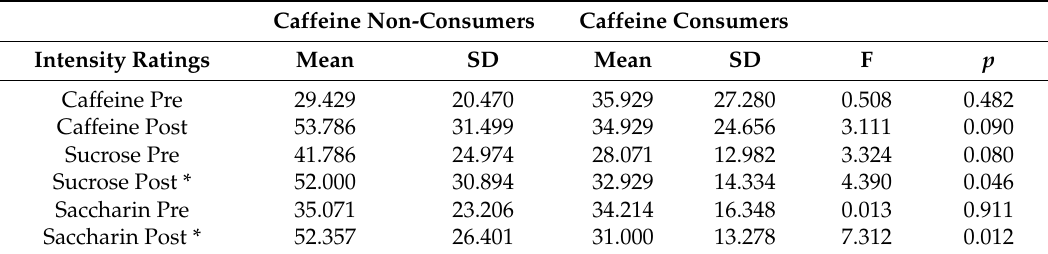
Table 3. Intensity ratings for caffeine non-consumers and matched caffeine